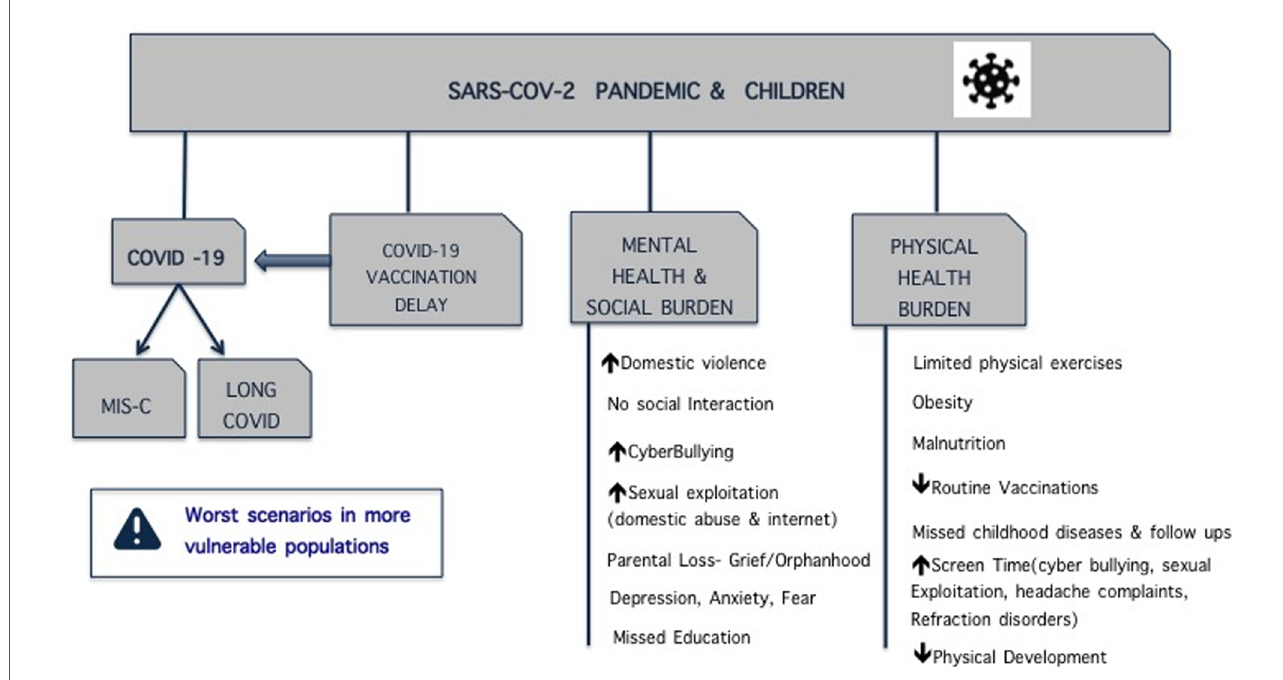
FIGURE 1. Effects of COVID-19 on children ’ s